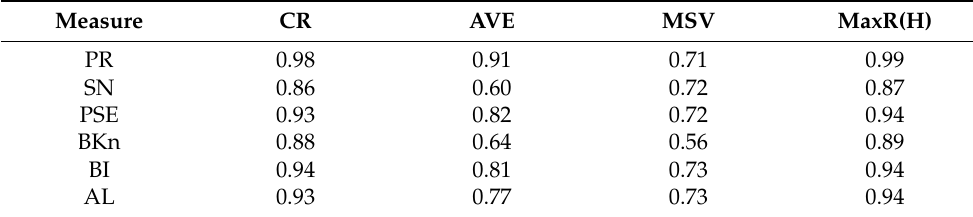
Table 3. Reliability and validity